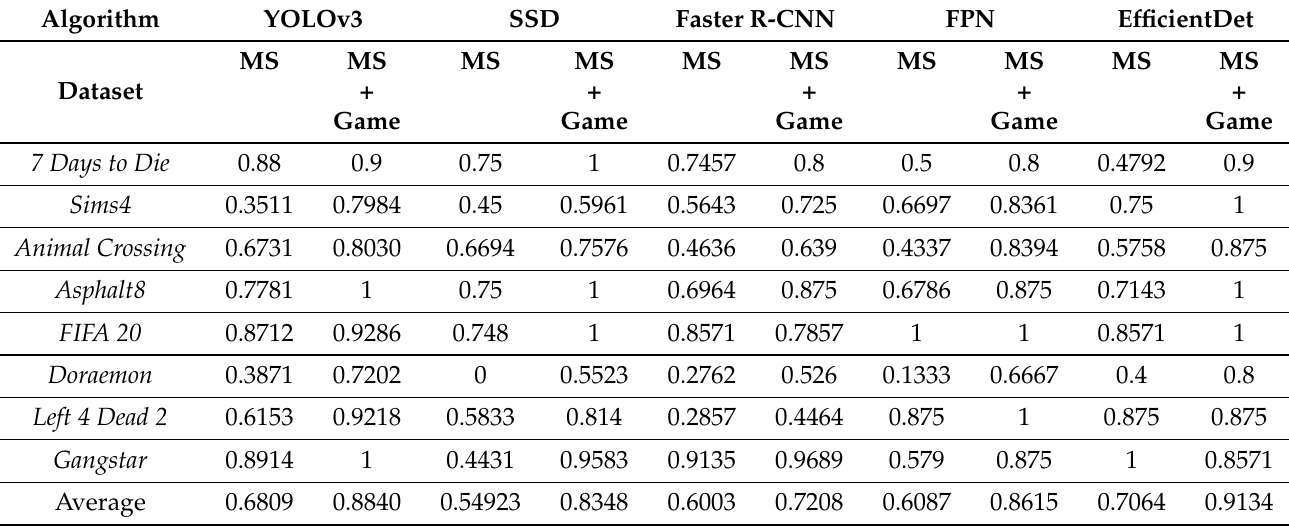
Table 3. The comparison of mAPs for each game. We compared five object detection algorithms pre-trained by MS COCO and retrained by MS COCO with game scenes. Note that MS COCO is abbreviated as MS in the table.